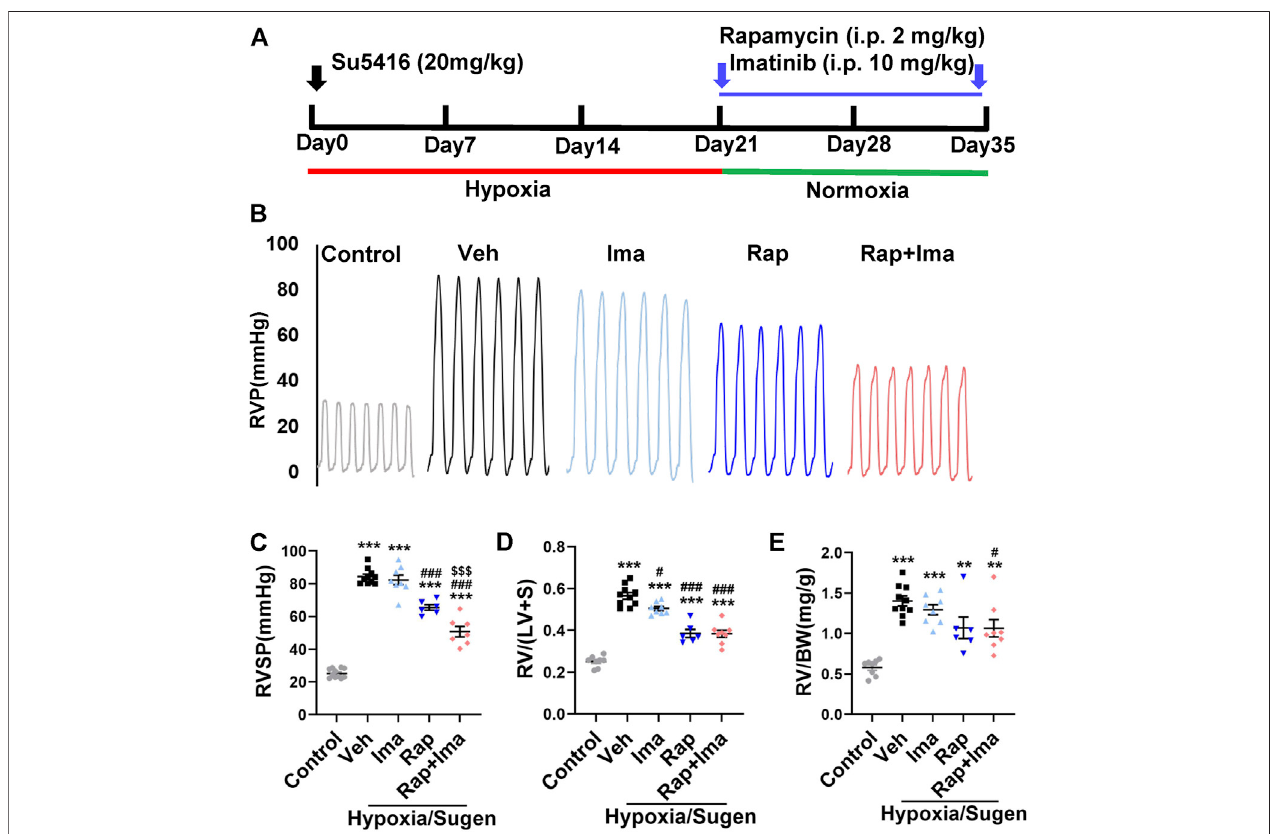
FIGURE 6 | Rapamycin combined with imatinib attenuates PH induced by Hypoxia/Sugen. (A) Schematic strategy for the Hypoxia/Sugen-induced PH rodent model and drugs administration. (B) Representative record of right ventricle pressure (RVP) in control and Hypoxia/Sugen treated with vehicle (Veh), imatinib (Ima), rapamycin (Rap) or combination of rapamycin and imatinib (Rap + Ima). (C,D,E) Summarized data showing RVSP, Fulton index [RV/(LV + S)] and the ratio of right ventricle weight to body weight (RV/BW) respectively. Data are presented as the mean ± SE. One-way ANOVA was used for statistical analysis. *** p < 0.001, ** p < 0.01, * p < 0.05versuscontrol; ### p < 0.001, ## p < 0.01, # p < 0.05 versus Hypoxia/Sugenwith vehicle; $$$ p < 0.001, $$ p < 0.01, $ p < 0.05versusHypoxia/Sugen with